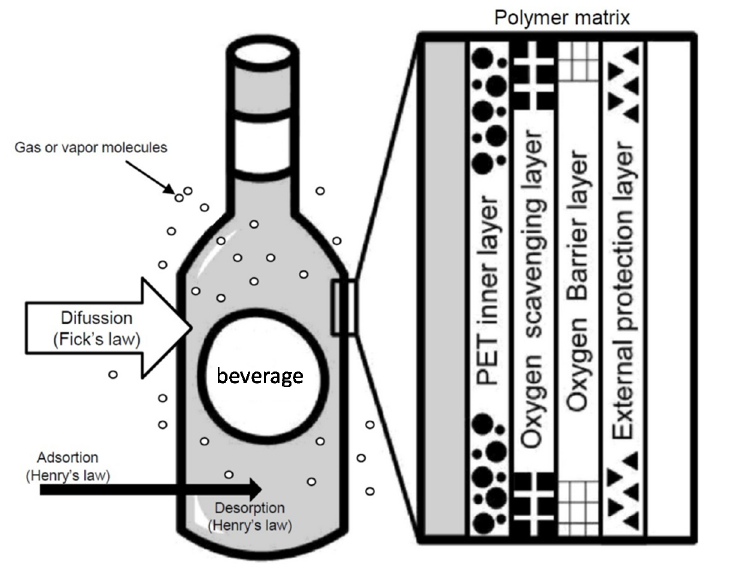
Figure 1. Scheme for the general mechanism of gas permeation through a multilayer beverage packaging system including an oxygen